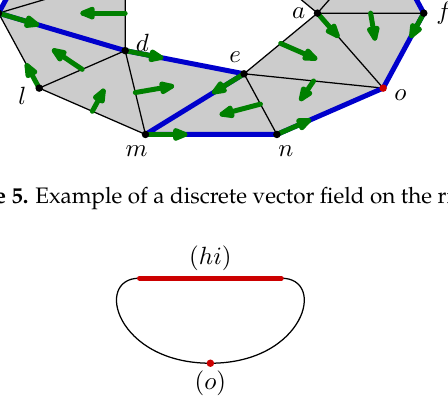
Figure 6. Morse complex of the ring from the discrete vector field of Figure